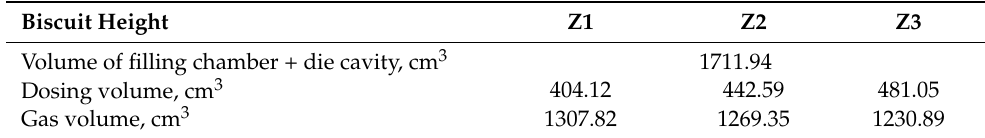
Table 6. Volume of gas and melt and its dependence on biscuit height. Biscuit Height